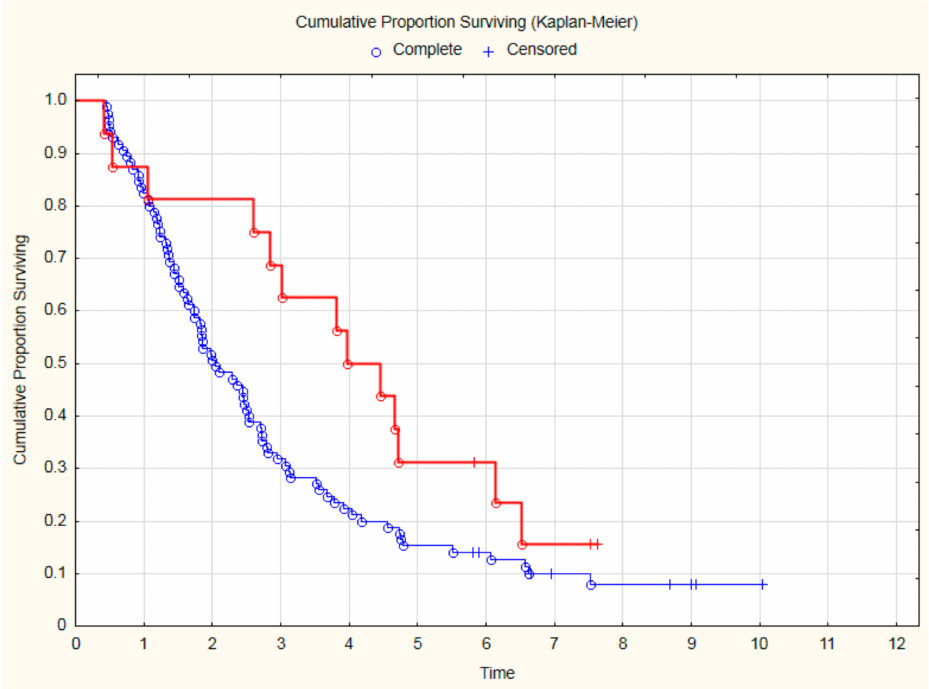
Figure 5. The overall survival among 101 CVD patients treated with beta-blockers and statin (red line) in comparison to patients without such therapy (blue line) after CRT ( p = 0.035,